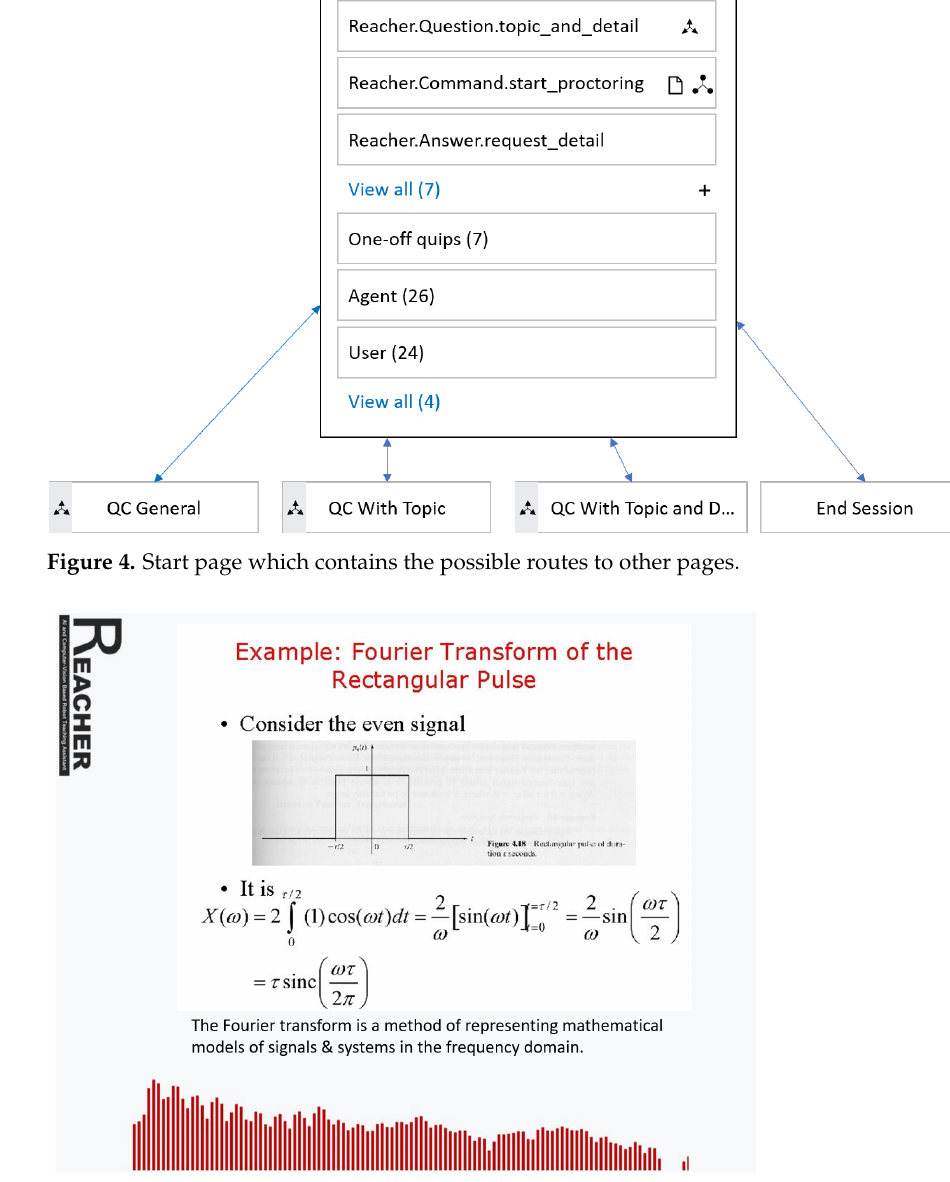
Figure 5. User interface where the upper part displays the main content retrieved, and the lower part shows the audio